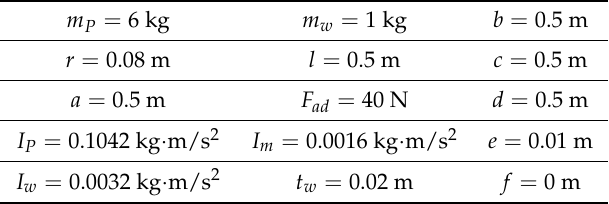
Table 2. Robots parameters for numerical